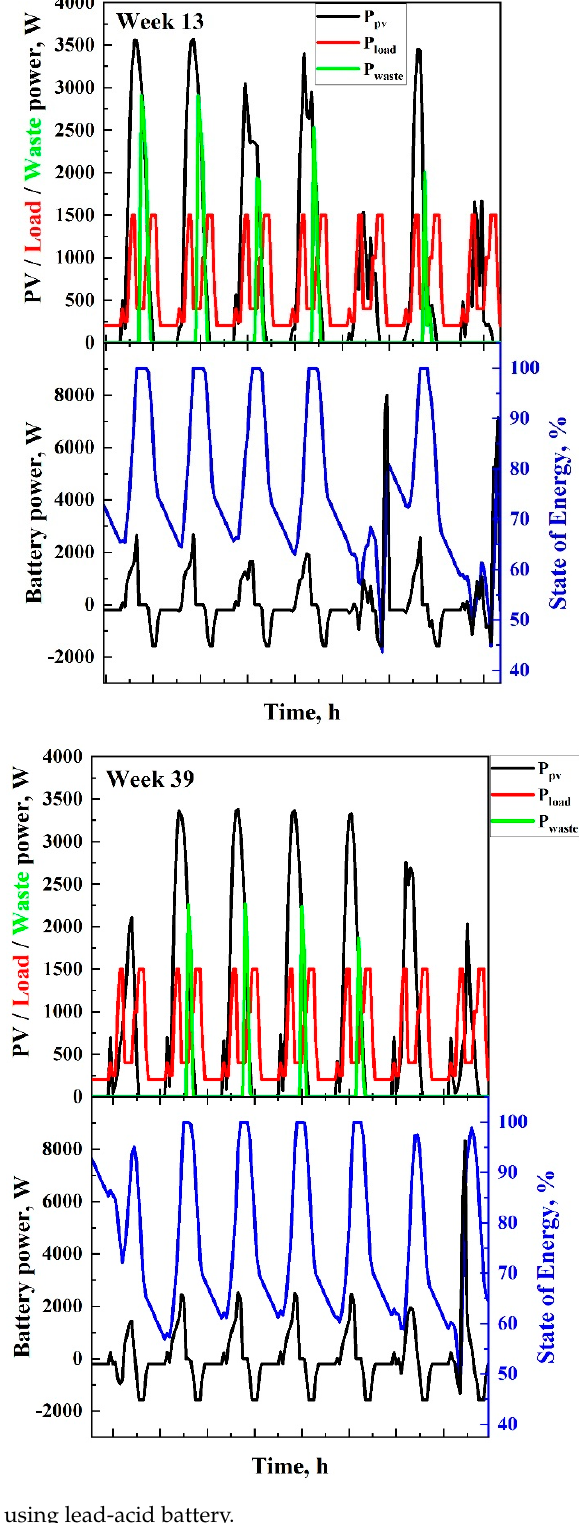
Figure 6. System performance using lead-acid battery.